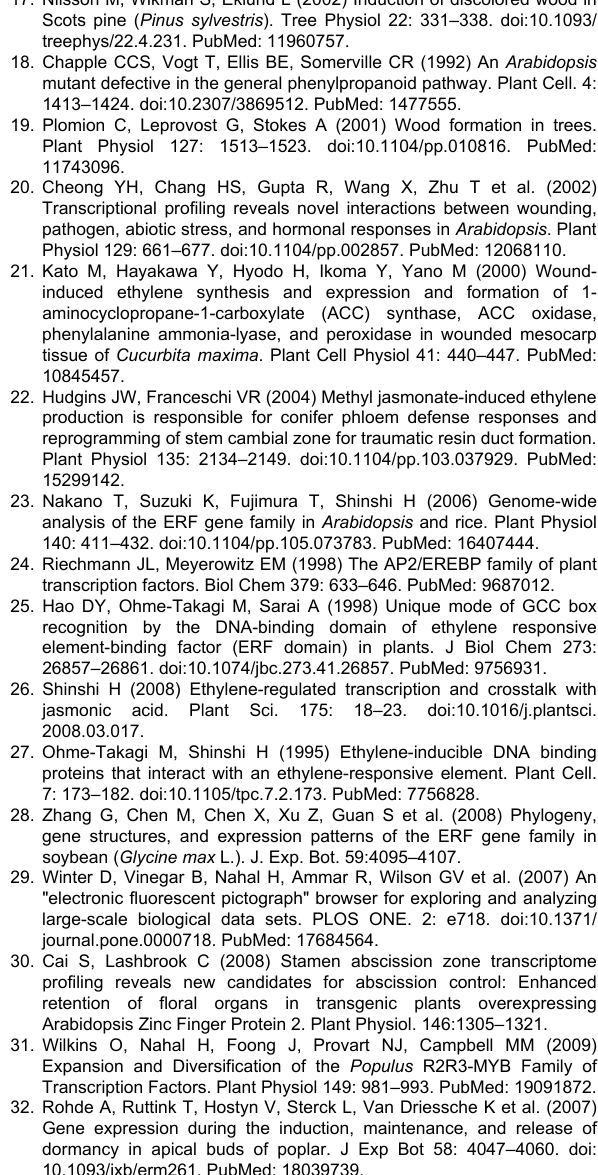
Figure S1. Southern blot result for the copy number of JnRAP2-like in black walnut. Two Enzymes, Xhol and EcoRV, were used for digestion of the genomic DNA in black walnut. 2.7kb was used for positive